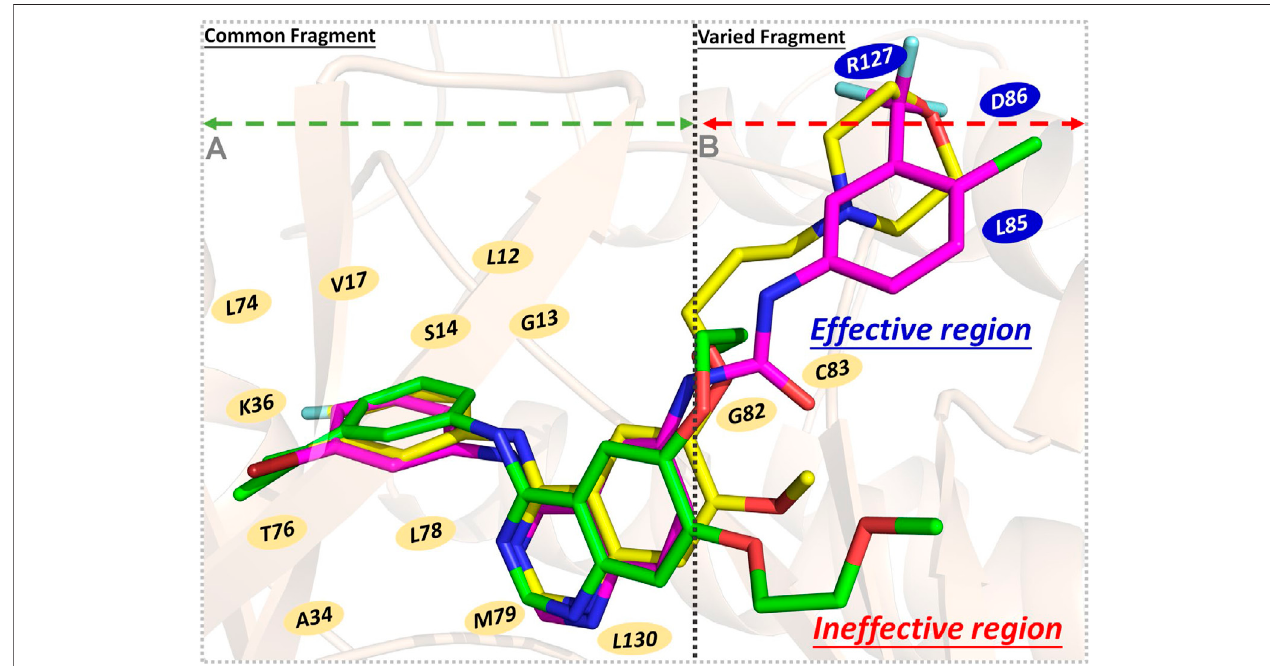
FIGURE8| Schematicdiagramofthreeligands ’ bindingmodesintheEGFR-ge fi tinibisinyellow,erlotinibisingreen,and Compound7i isinmagenta: (A) Region A, the residues interacting with the common fragment; (B) Region B, the residues interacting with the varied fragment.